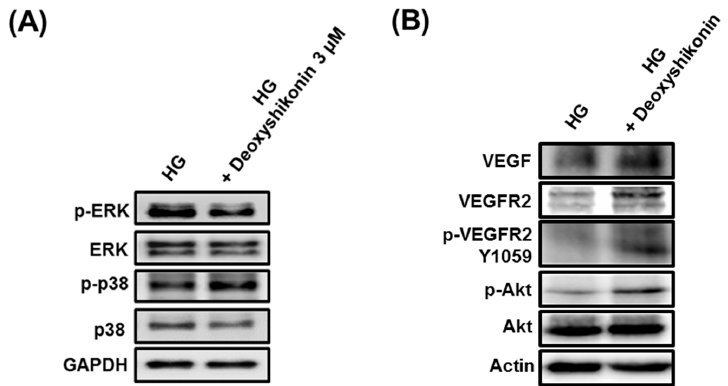
Figure 6. Effect of deoxyshikonin on MAPKs and VEGFR2 signaling in high glucose-exposed HUVECs. HUVECs were seeded into 10-cm dish, then the culture medium was changed to high glucose (30 mM) condition. After that, HUVECs were maintained in high glucose condition for 3 days, then treated with deoxyshikonin (3 uM) for 24 h. Whole cell-lysates were immunoblotted with the specific antibodies indicated. GAPDH and β -Actin (Actin) served as an internal loading control.